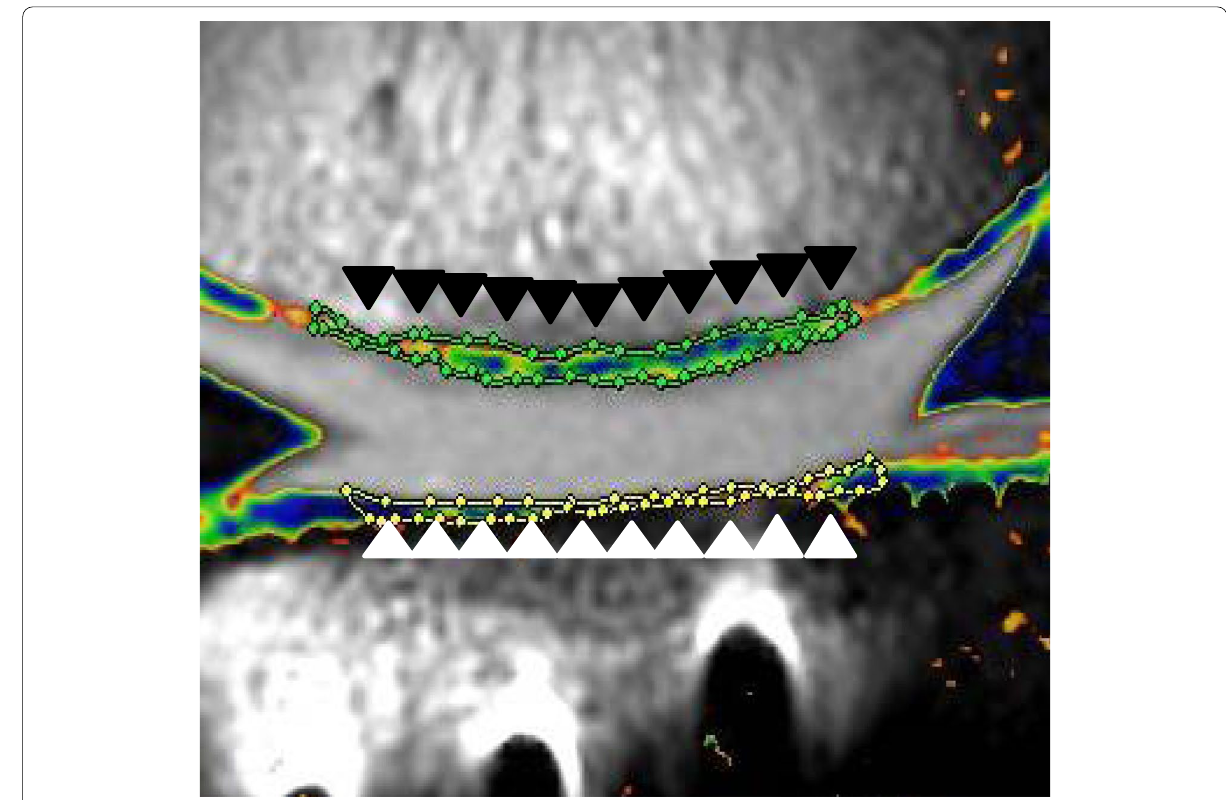
Fig. 1 Regions of interest (ROIs) were drawn around the repair site. The ROIs for measurement of T2 relaxation times in the lateral femoral condyle (black arrowhead) and tibial plateau (white arrowhead) are